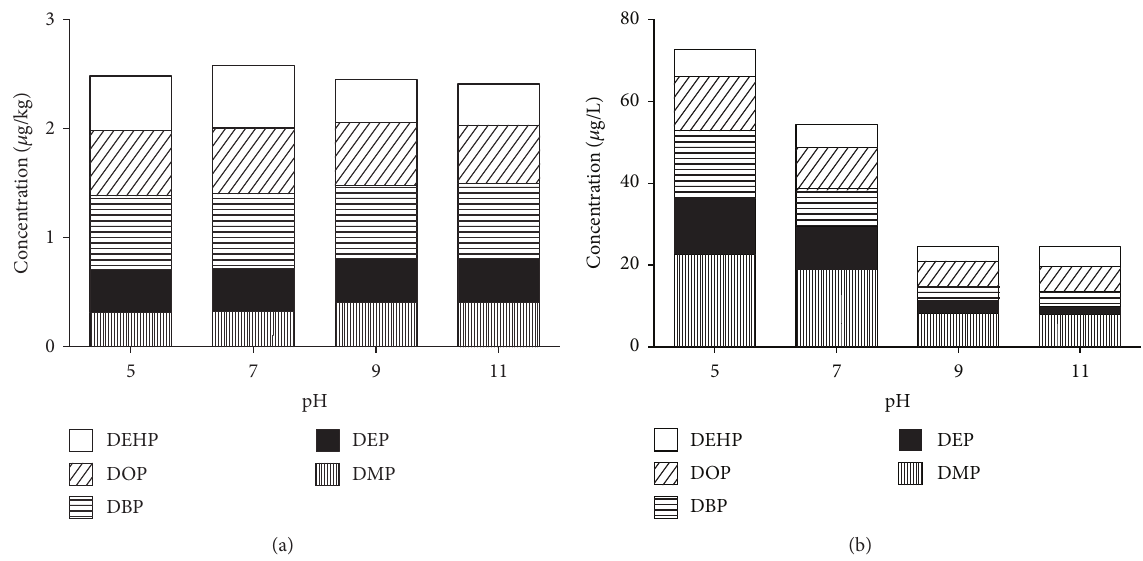
Figure 4: The concentrations of PAEs in sludge (a) and water (b) at different pH (initial concentration = 80 𝜇 g/L, temperatures = 25 ∘ C, and experiment duration = 2